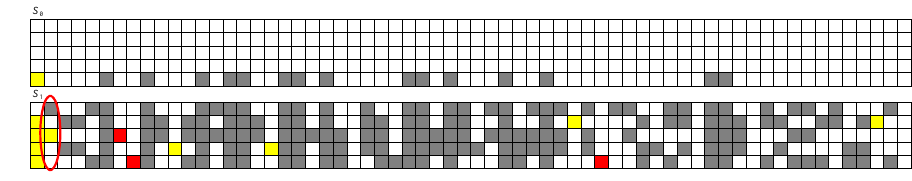
Figure 3: Diffusion of v i with k 0 (0) = 0